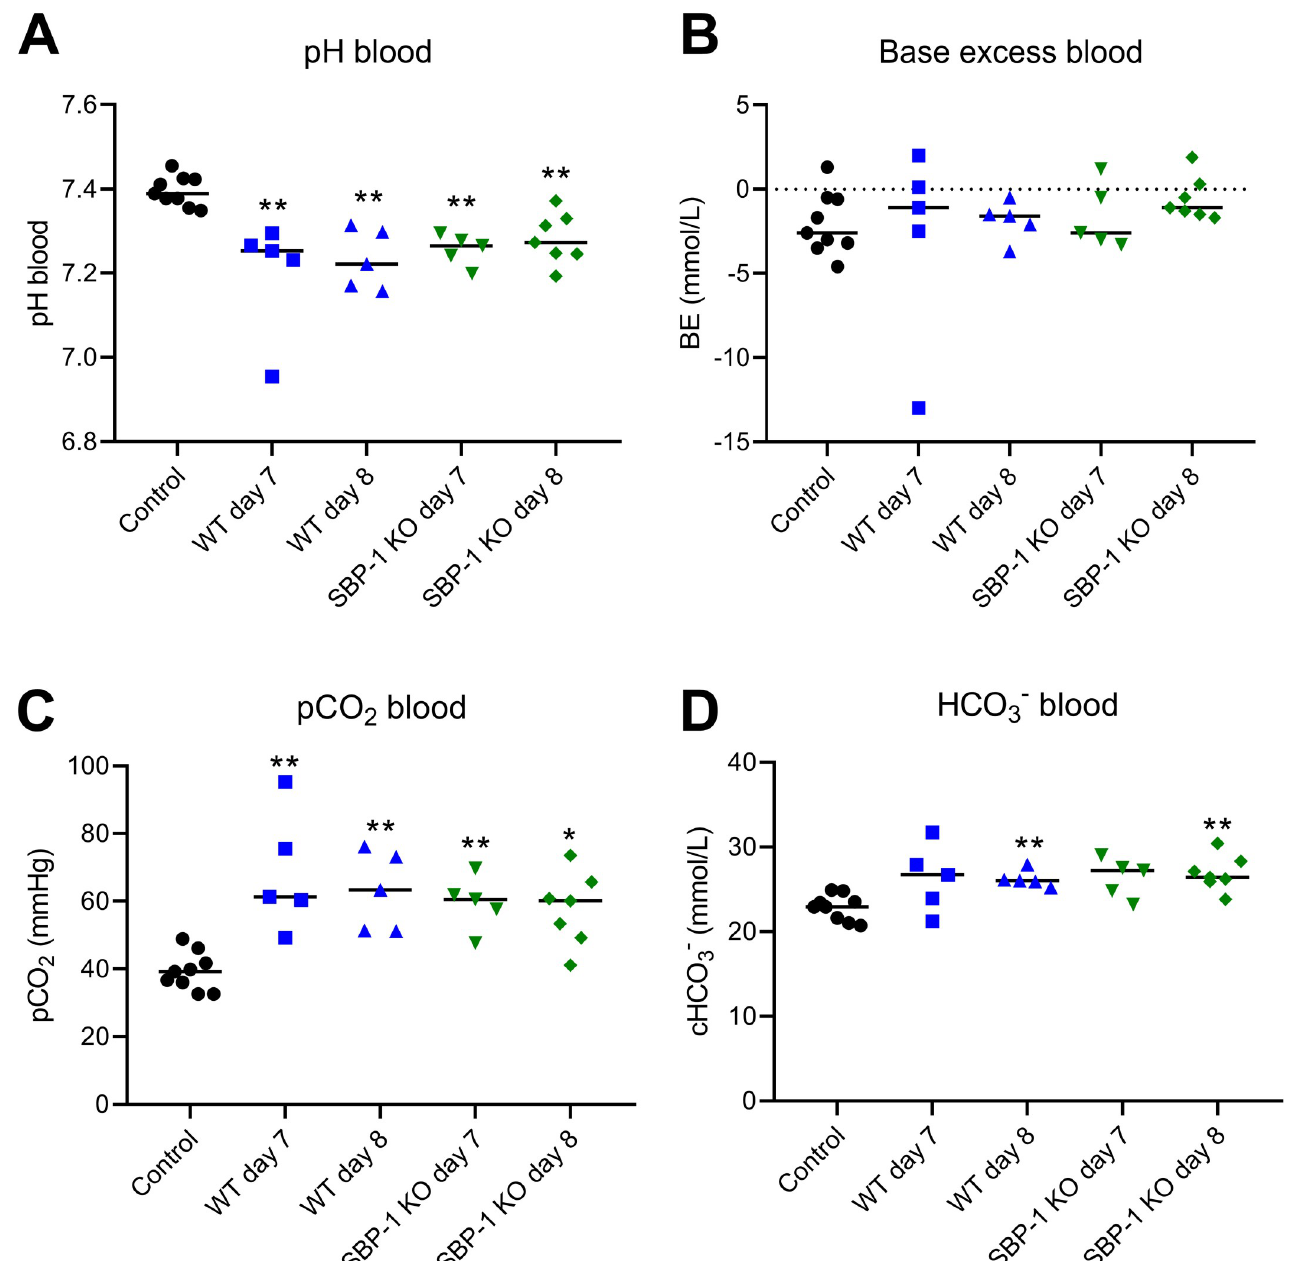
Fig 5. Respiratory acidosis in experimental MA-ARDS. C57BL/6 mice were infected with WT and SBP-1 KO Pb NK65 parasites. Retro-orbital punctures were performed and collected blood was analysed in the Epoc Blood Analysis System at indicated timepoints. (A) pH, (B) base excess, (C) partial pressure of CO 2 and (D) HCO 3- were measured in the blood. Asterisks above data points indicate significant differences compared to control mice, asterisks above a horizontal line show significant differences between infected groups. Data of three experiments, n = 5–9 per group. Mann-Whitney U test with Holm-Bonferroni correction for multiple testing (number of tests = 8) was